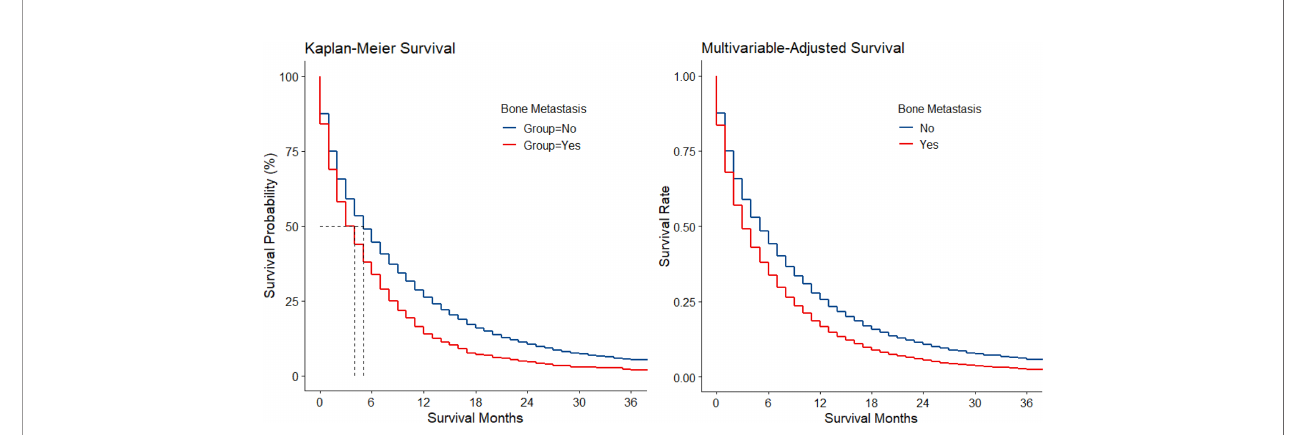
FIGURE 1 | Kaplan – Meier and multivariable-adjusted survival by bone metastasis status in metastatic gastric adenocarcinoma.